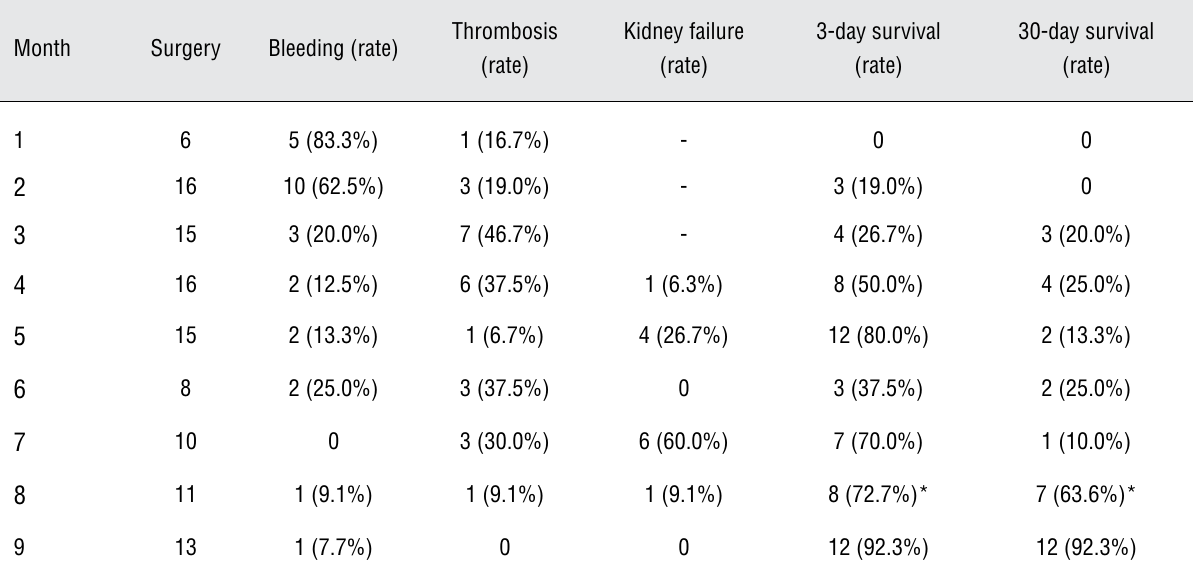
Table 1 - Surgical results by